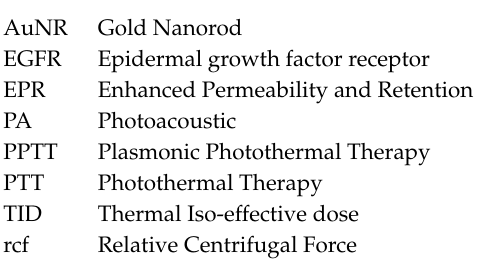
Figure S1: A schematic representation of the differences between pulsed and continuous wave